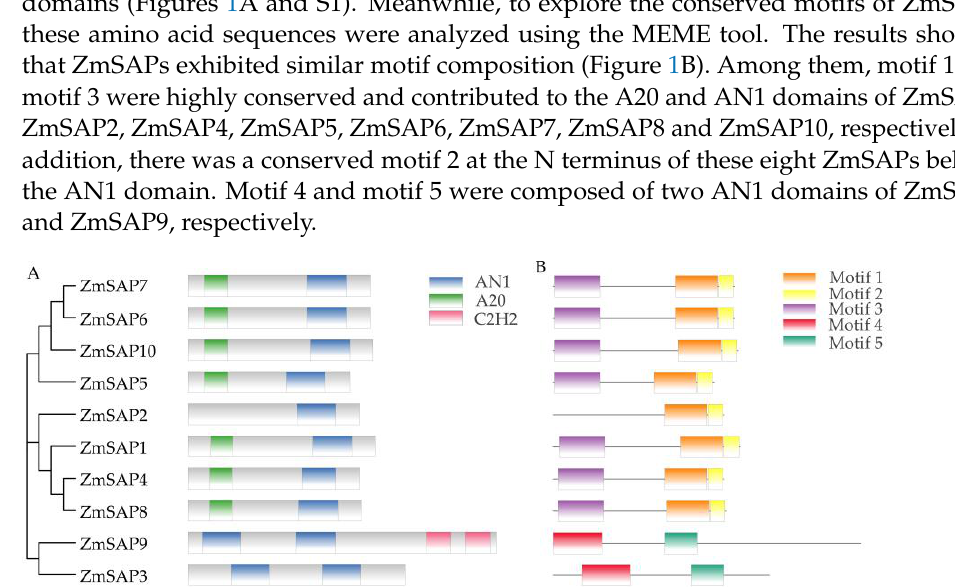
Table 1. Characteristics of ZmSAP genes in Zea mays .